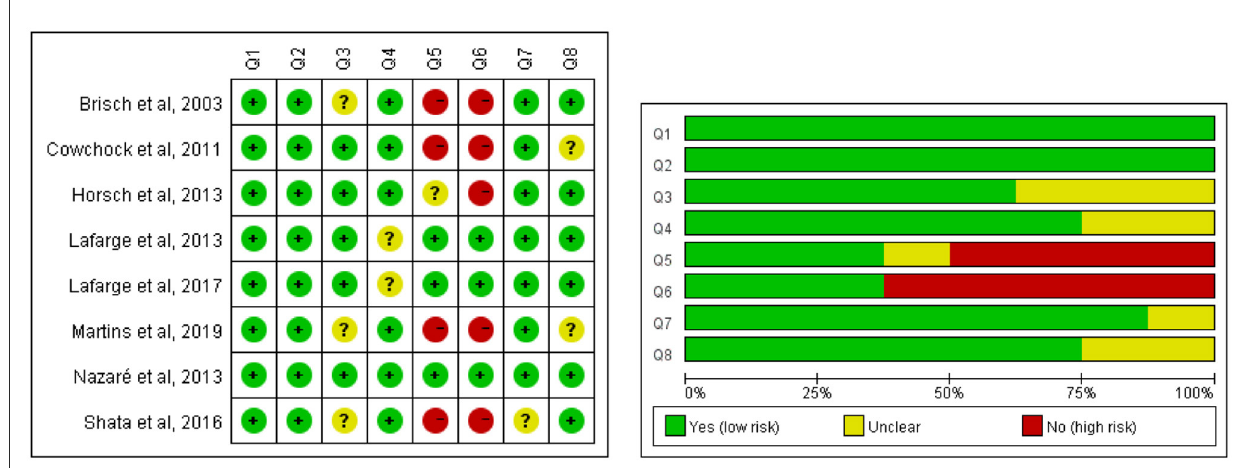
FIGURE2 Methodological quality of quantitative studies. Q1: Were the criteria for inclusion in the sample clearly defined? Q2: Were the study subjects and the setting described in detail? Q3: Was the exposure measured in a valid and reliable way? Q4: Were objective, standard criteria used for measurement of the condition? Q5: Were confounding factors identified? Q6: Were strategies to deal with confounding factors stated? Q7: Were the outcomes measured in a valid and reliable way? Q8: Was appropriate statistical analysis used?